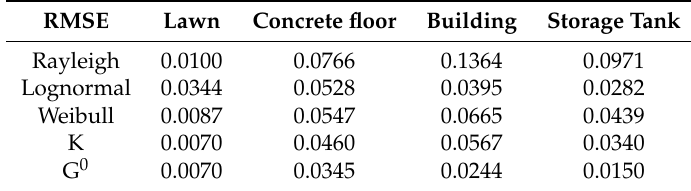
Figure 7. The fitting result of the chosen areas. ( a ) Lawn. ( b ) Concrete floor. ( c ) Building. ( d ) Storage tank. Table 4. The RMSE values of the fitting